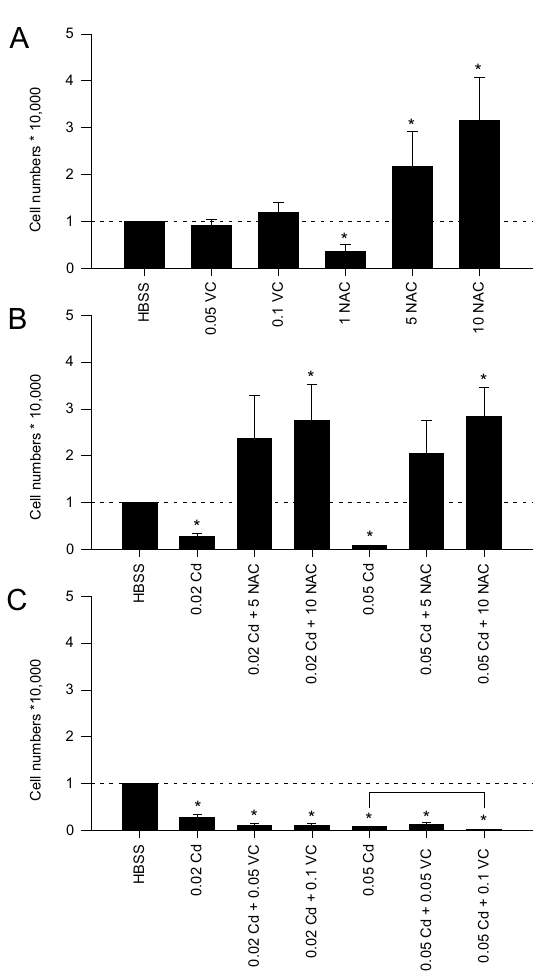
Figure 2. Cell density assay (Hoechst 33342) with Z3 zebrafish cells. ( A ) Effect of vitamin C (VC) and N -acetylcysteine (NAC) on HBSS incubated cells; ( B ) Recovery from HBSS and Cd treatment using NAC; ( C ) Recovery from HBSS and Cd treatment using VC. Cell numbers were normalized to 10,000 cells of the HBSS control. Statistical analysis was performed prior to data normalization using a t -test. Exposures were compared to HBSS treatment (* p ≤ 0.05). Square bracket indicates statistical significance from comparison of normalized data. Values are mean ± standard error from 3 biological replicates.